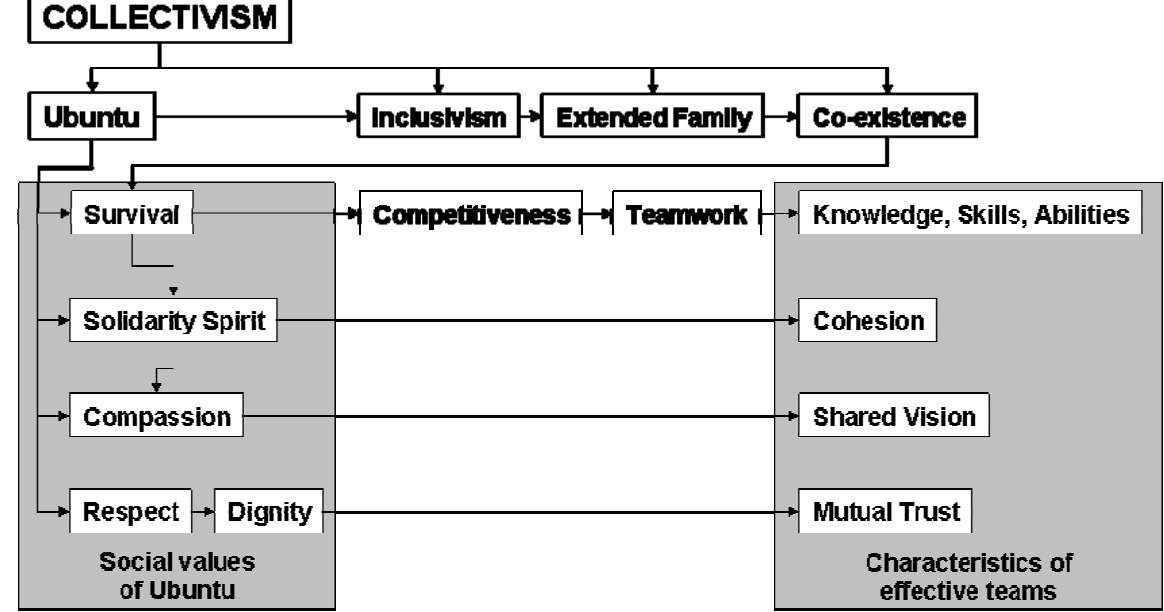
Figure 2: Central category and subcategories that emerged from the study African culture in South Africa can be characterised as collectivistic (Nussbaum, 2003). The Collectivistic nature of the African culture can be seen in the meaning of the underlying value system of ubuntu. Ubuntu means humanity, or, in a simpler explanation, that the existence of an individual impacts on others around him or her. As such, it is not about the individual, but rather about the